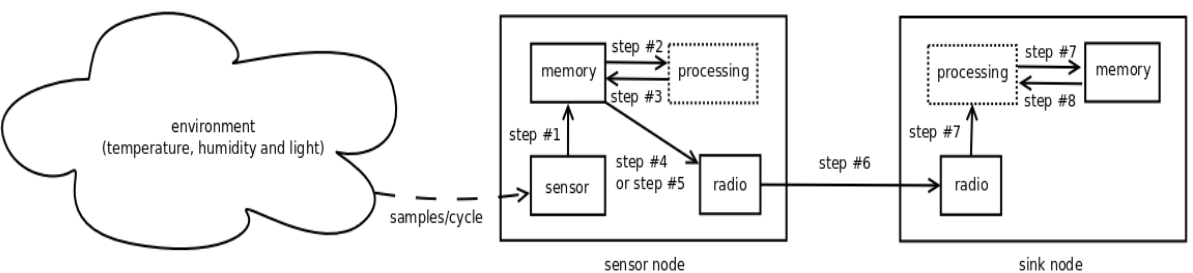
Figure 4. Proposed mechanism